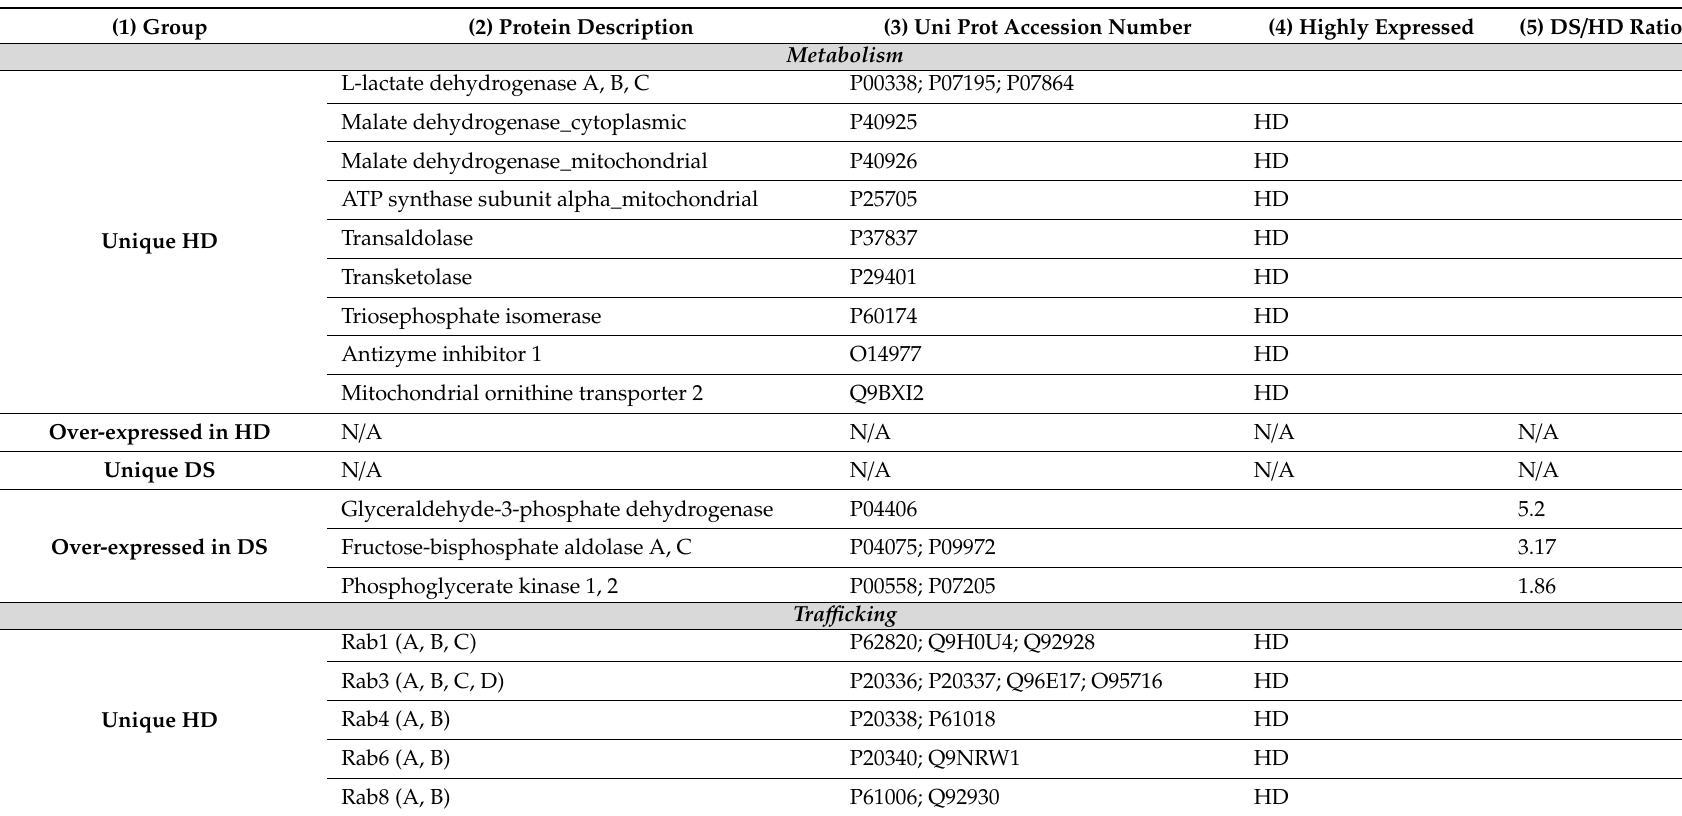
Table 2. Di ff erentially expressed proteins in DS and HD groups identified using HD-MS E label-free mass spectrometry analysis clustered in the related molecular networks. (1) Experimental group in which proteins are mainly expressed; (2) protein name; (3) accession number according to UniProtKB / Swiss-Prot Protein Knowledgebase; (4) protein found highly represented (defined as unique) in DS or HD PBMCs protein extracts; (5) ratio of expression between DS and HS according to quantitative expression analysis by PLGS